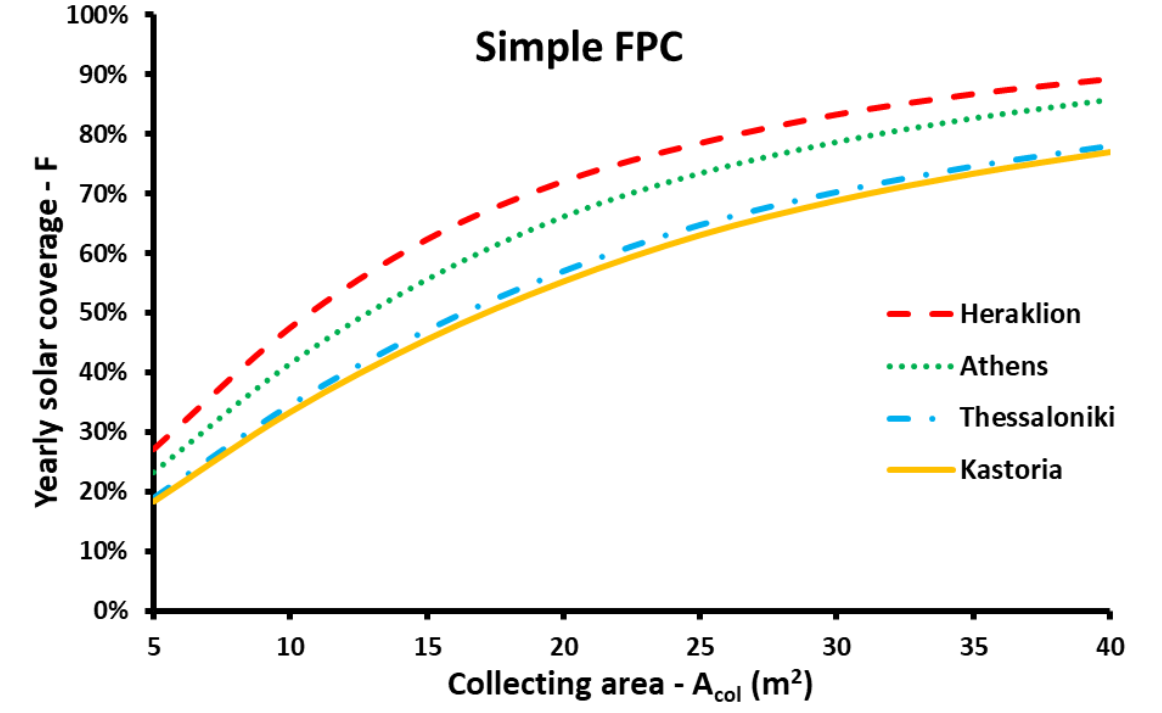
Figure 10. Yearly solar coverage with simple FPC for the examined locations with optimized tilt angle.